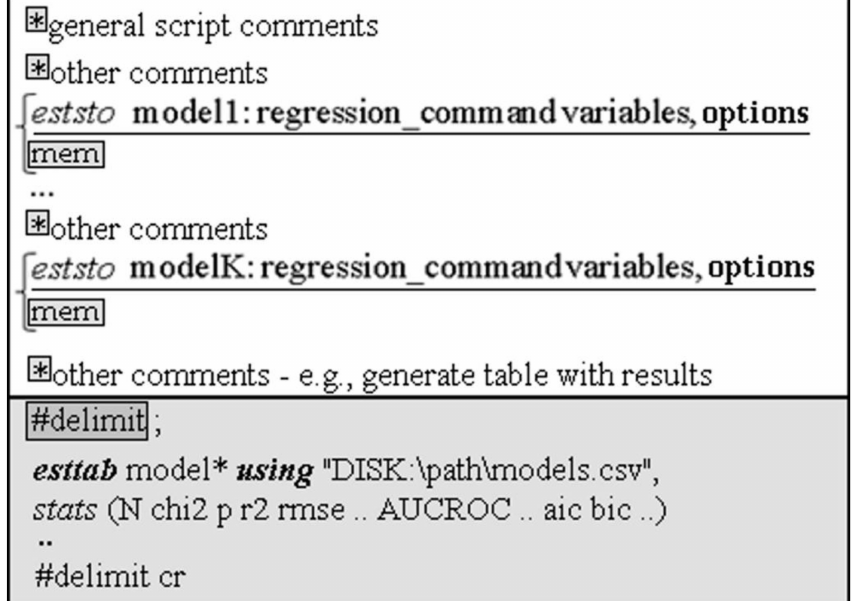
Figure 2. Simple steps in a script using MEM and meant to produce tables with results (coefficients, errors, and significance) for regression models and also performance metrics such as default statistics together with additional ones brought by